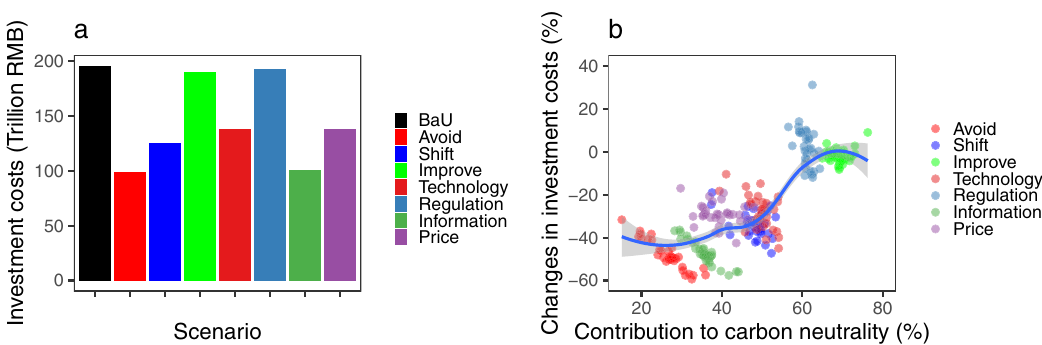
Fig. 6 Economic costs under different strategies and instruments. a Cumulative investment costs from 2015 to 2060 in 13 scenarios. b Correlation between the contribution to carbon neutrality and the investment costs in China ’ s 31 provinces. The shaded areas in panel b show 95% con fi